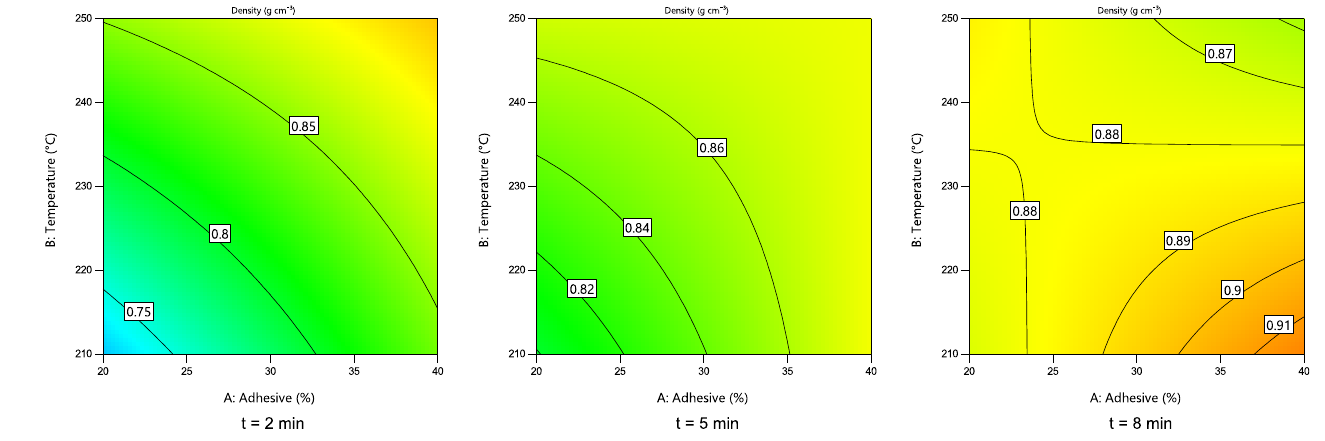
Figure 8. Changes in the density of the boards depending on the hot-pressing parameters.